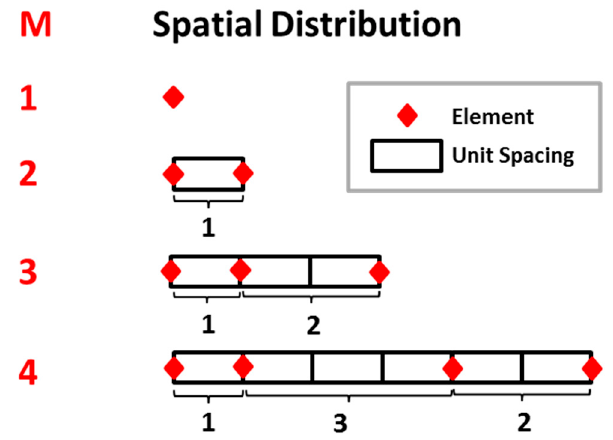
Figure 2. The four zero-redundancy linear arrays and their spatial distribution, where red diamonds represent spatial positions of elements, white bars represent spacing (spatial distance) between adjacent elements.